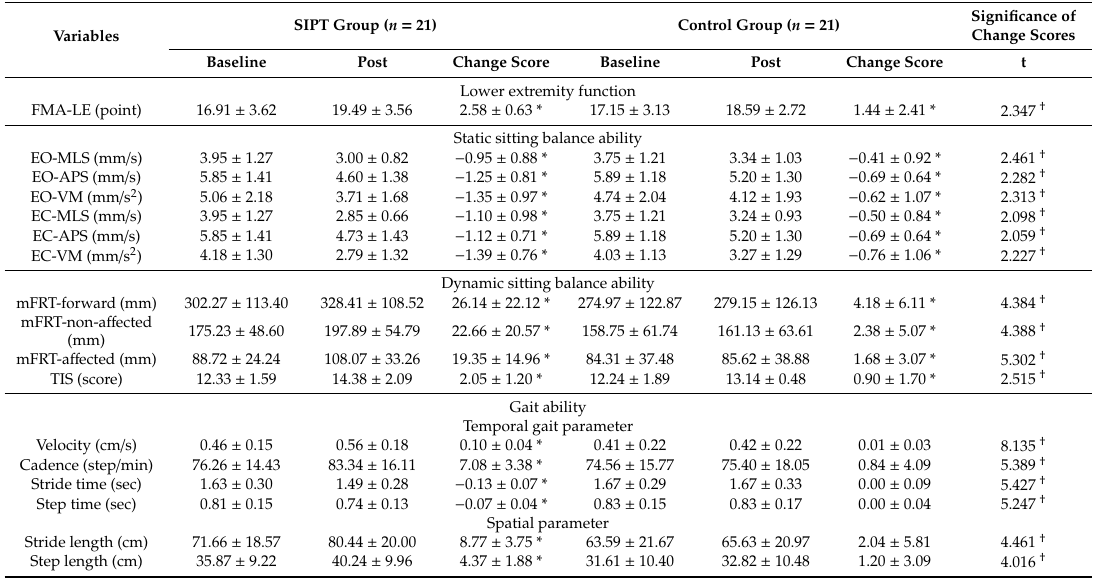
Table 2. Comparison of measures within groups and between